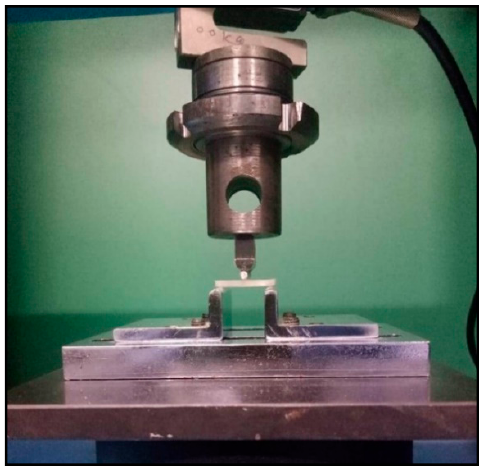
Figure 2. Specimen attached to universal testing machine for three point bending test.